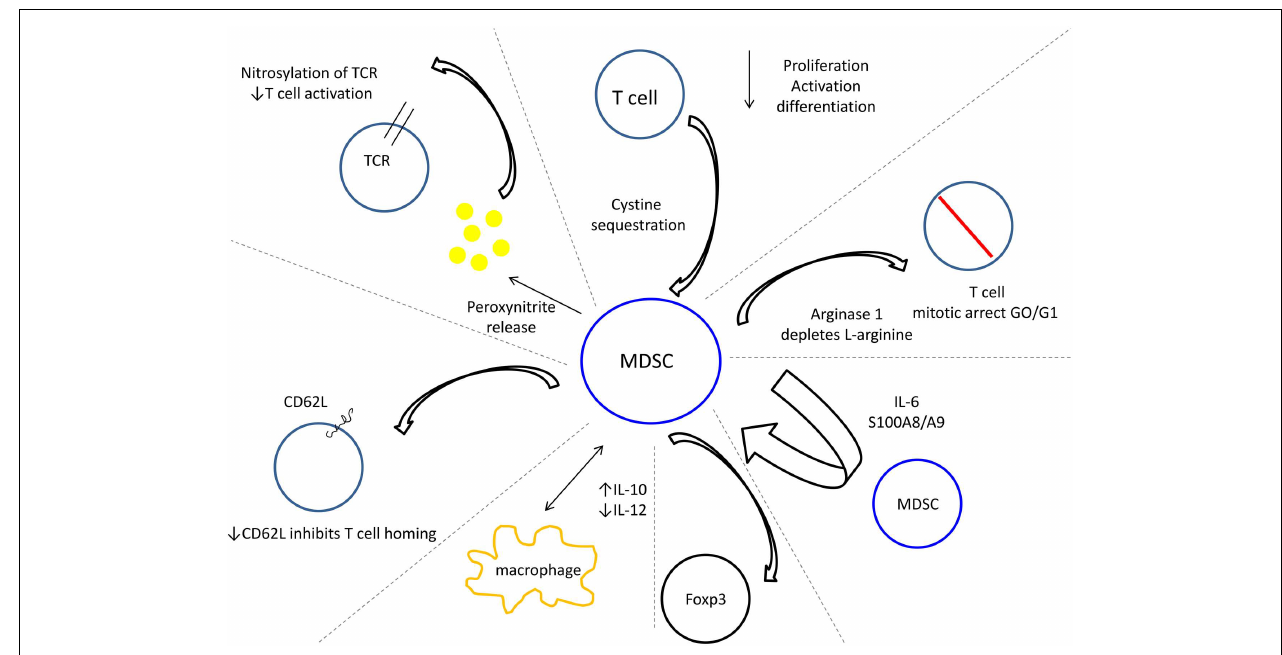
FIGURE 1 | Myeloid derived suppressor cells use multiple mechanisms to dampen anti-tumor immunity.